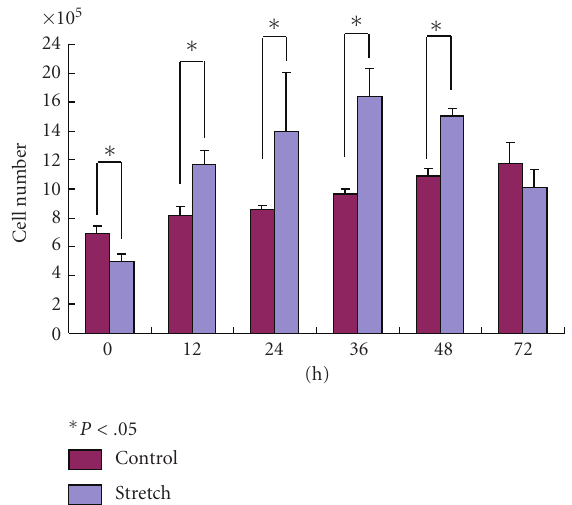
Figure 4: The numbers of cells in the stretching group were significantly less than the control group at 0 hour but were increased compared to the control group at 12, 24, 36, and 48 hours.